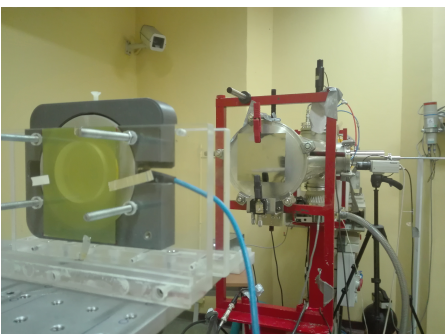
Figure 3. Picture of the experimental setup. An ionization chamber is placed between two PMMA supports on a moving table. A piece of Gafchromic EBT3 film is attached to the rear of the second PMMA support, after a circular collimator. The beam, coming from the front, traverses a tungsten scattering foil of variable thickness and approximately 50cm of air, before reaching the ionization chamber. Table 1. Material and thickness of the experimental setup components traversed by the proton beam. The column “order” indicates the sequence in which the layers of material are placed. Element Material Order Thickness Exit window Mylar 1 125 µ m Scattering Foil